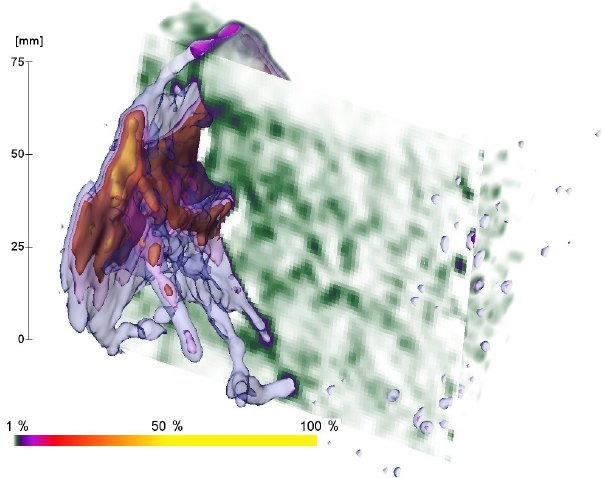
Figure 10. Frame 5 from Fig. 8 with a vertical slice from Figure 9 and isosurfaces at 50, 20, 10, 5, and 2% of the maximum